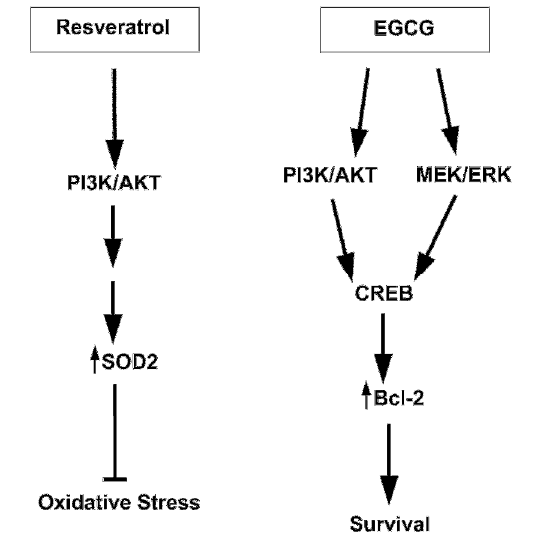
Figure 8. Modulation of pro-survival protein kinase pathways by